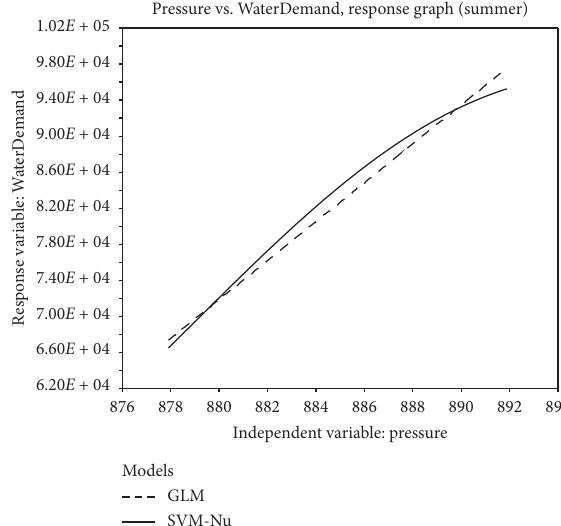
Figure 13: The reaction of water consumption to air pressure with summer conditions using GLM and SVM-Nu models. Pressure vs. WaterDemand, response graph (winter)